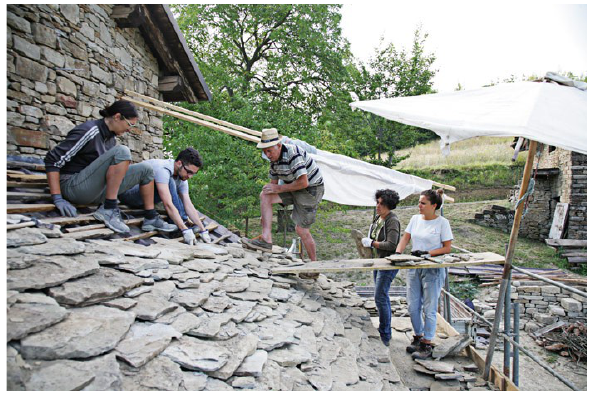
Figure 3. The reconstruction of a roof